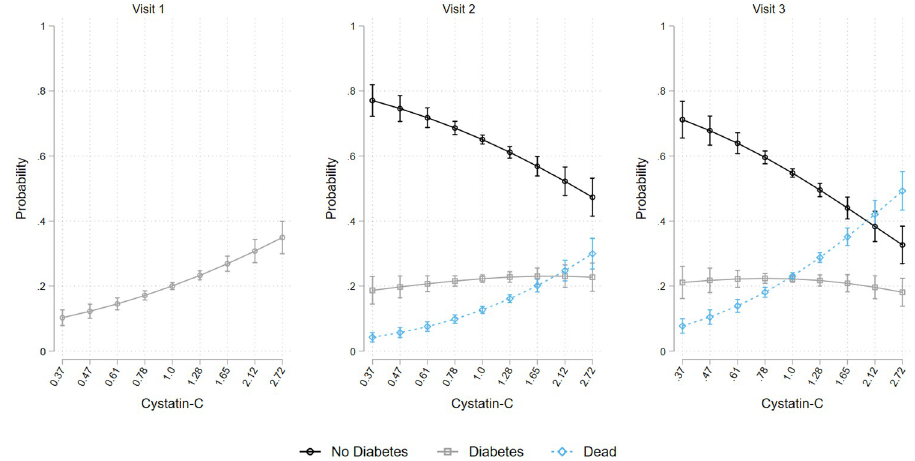
Fig 1. Prevalence of (marginal probability and 95% confidence interval) no diabetes, diabetes, and death status at visit 1, visit 2, and visit 3 over Cystatin-C levels.